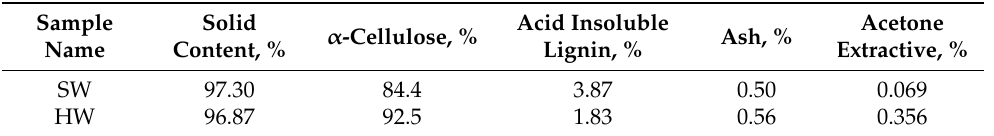
Table 1. Chemical compositions of SW and HW chemical kraft pulps. Sample